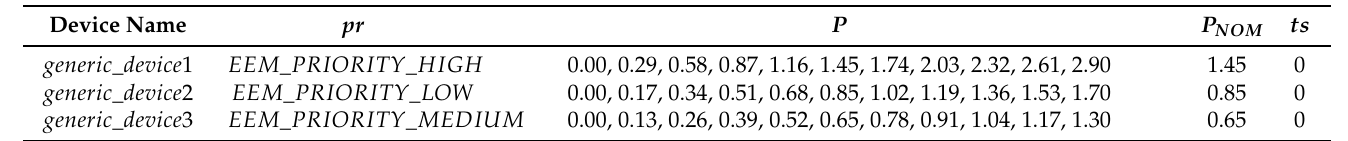
Table 3. List of parameters adopted for research.